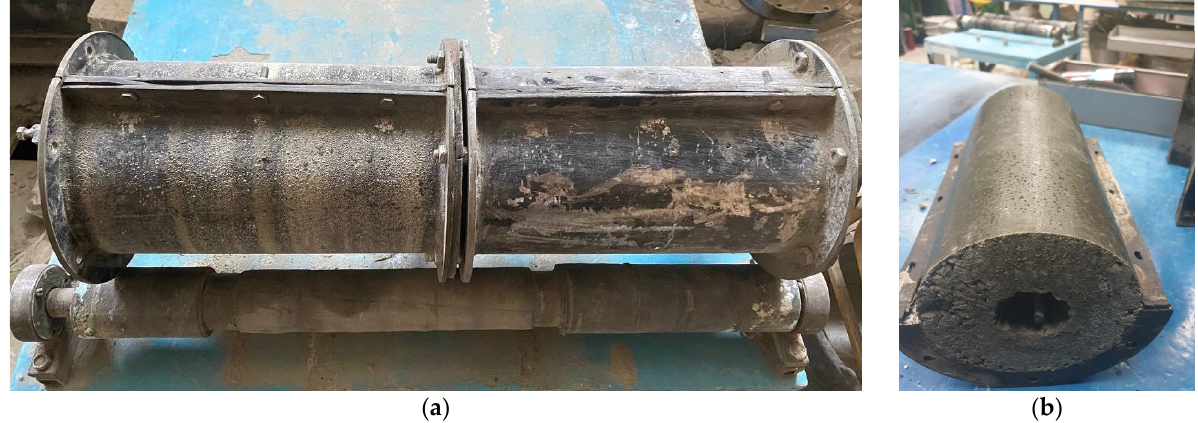
Figure 1. Photograph of an annular section specimen: ( a ) in a laboratory facility during molding; ( b ) during demoulding.